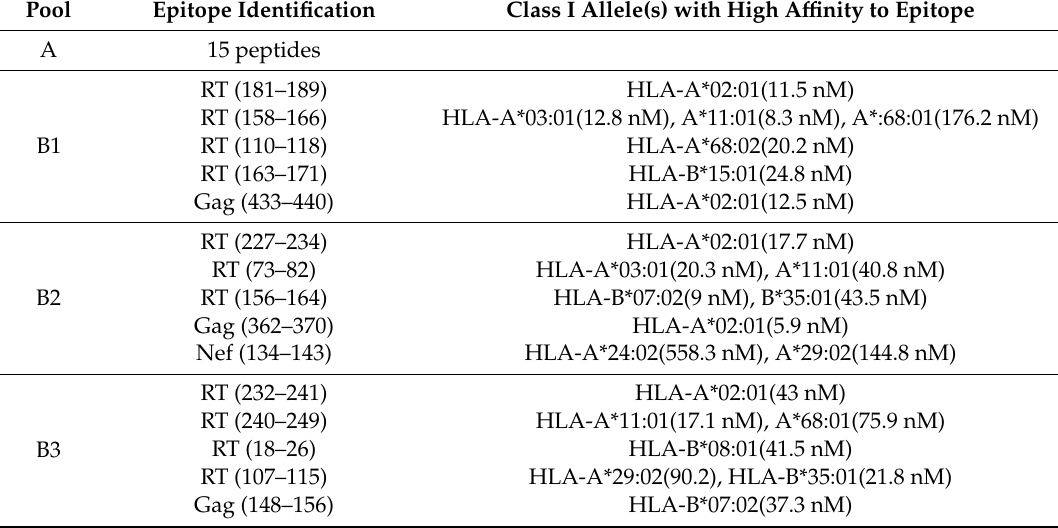
Table 1. HIV-1 peptides of Hla Fitted VACcine (HFVAC) and their presenting HLA alleles. Pool A contained all peptides while pools B1, B2 and B3 contained subgroups of pool A. The theorical MHC IC 50 is noted in the brackets. All MHC IC 50 theorical values were < 500 nM, with the exception of Nef(134-143) / HLA-A*24:02; this couple peptide / allele has been selected because it is considered in